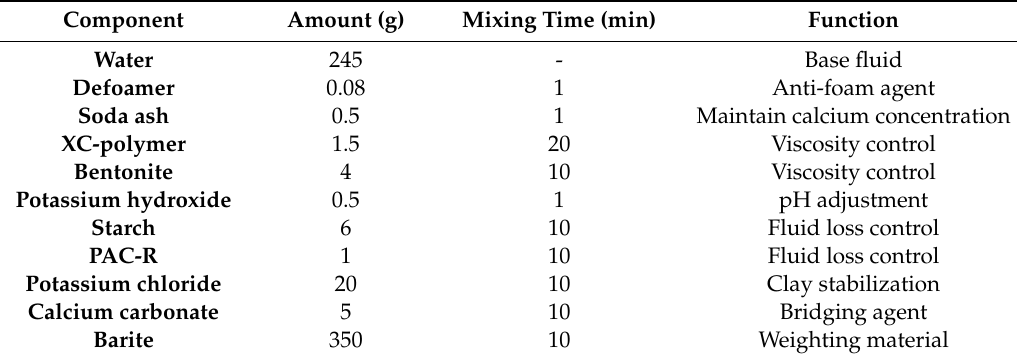
Table 1. Drilling fluid formulation used in this study.